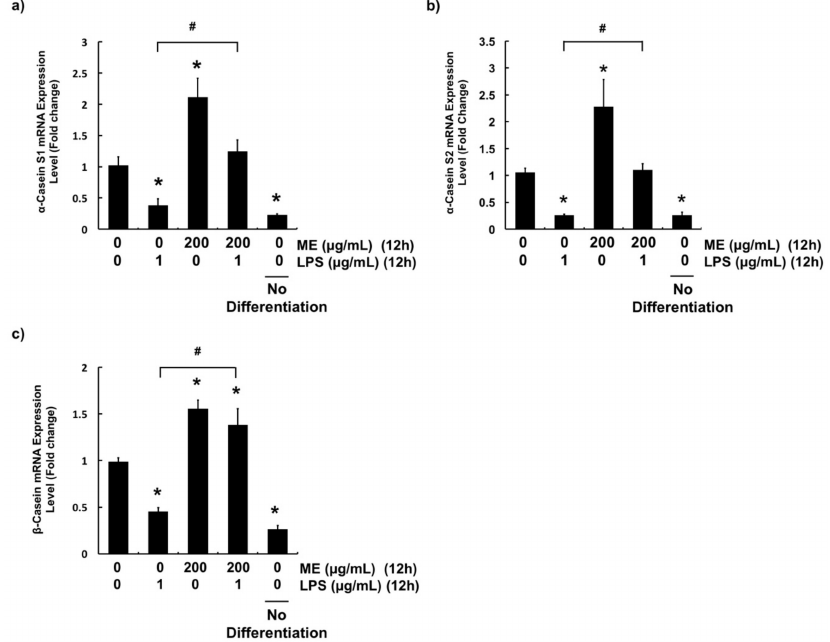
Figure 7. Gene expression levels of casein isoforms in di ff erentiated MAC-T cells. mRNA expression levels of ( a ) α -Casein S1 ( b ) α -Casein S2, and ( c ) β -Casein were determined. Cells were di ff erentiated for 8 d and treated with or without ME (200 µ g / mL) for 12 h followed by LPS treatment (1 µ g / mL) for 12 h. mRNA expression levels were measured using RT-PCR. mRNA expression levels were calculated relative to GAPDH expression. Values represent means ± SEM ( n = 3). *, significant di ff erence vs. control (No ME, no LPS) ( p < 0.05). #, significant di ff erence between the two treatment groups ( p < 0.05). ME = moringa